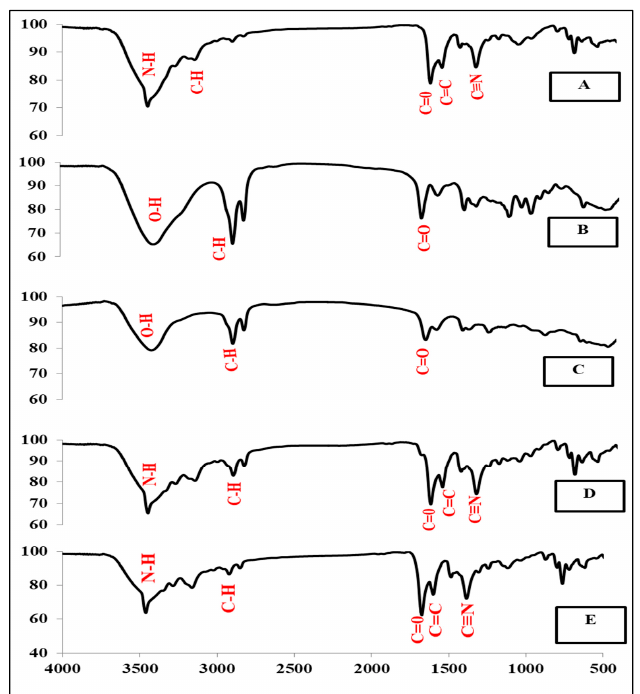
Figure 5. Infrared spectra of ( A ) pure carbamazepine, ( B ) glyceryl monostearate, ( C ) stearic acid, ( D ) solid lipid nanoparticle prepared with glyceryl monostearate, and ( E ) solid lipid nanoparticle prepared with stearic acid.